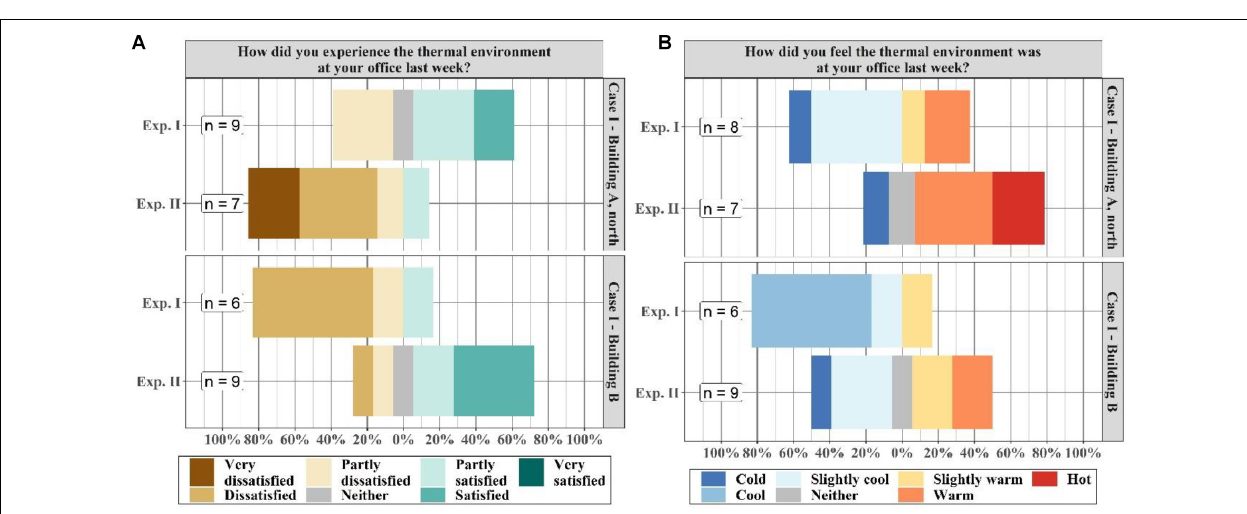
FIGURE 9 | Divergent bar plots of responses for the last week in Exp. I and II in case I. (A) Satisfaction with the thermal environment. (B) Thermal